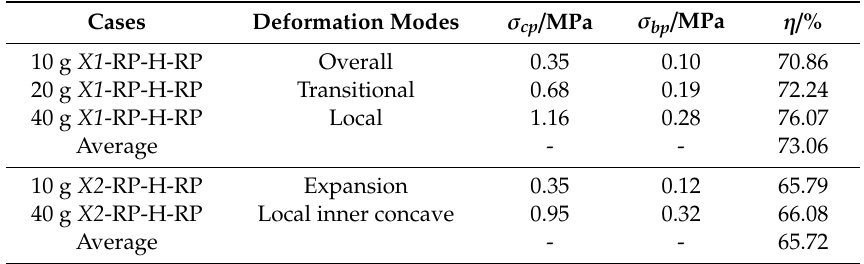
Figure 15. Stress-time curves of X2 -RP-H-RP. ( a ) Expansion mode and ( b ) Local inner concave mode. Table 2. The buffering effect under different equivalent explosive masses.